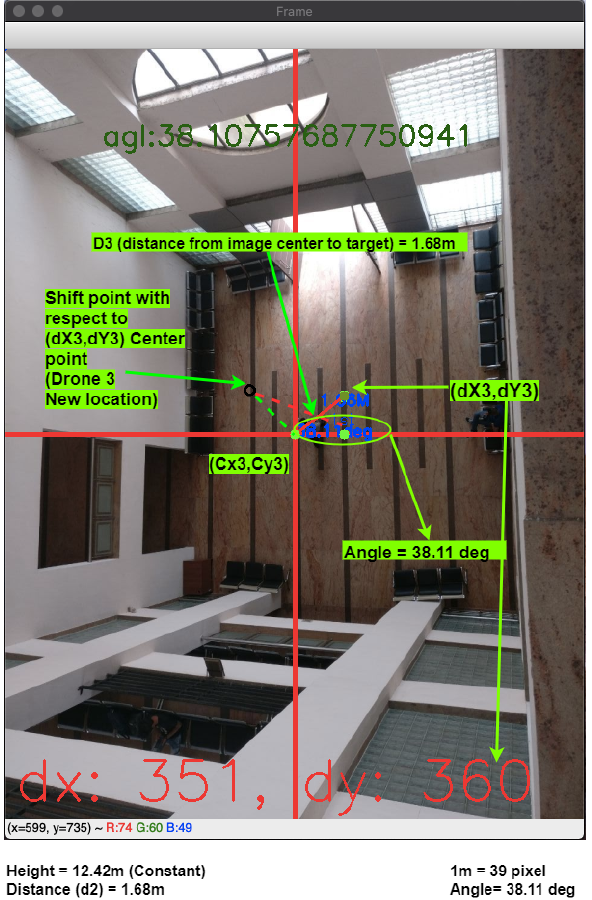
Figure 10. Parameter estimation and target localization in drone 3 image.